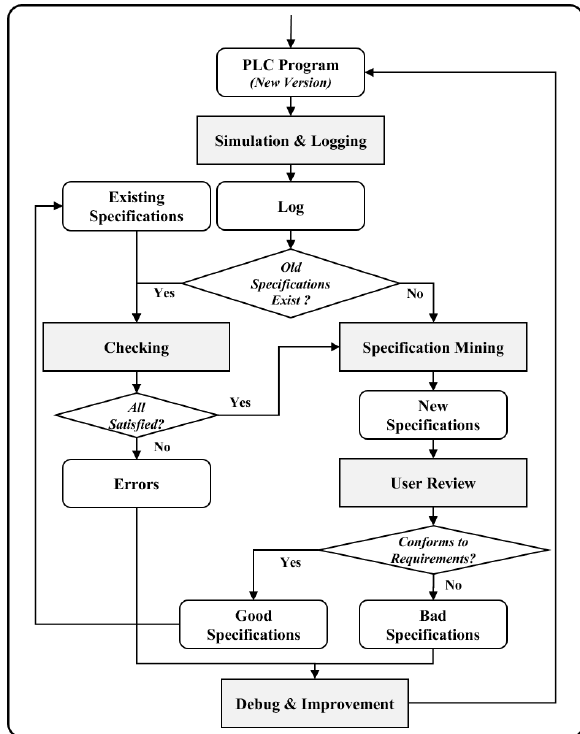
Figure 2. The workflow of the iterative